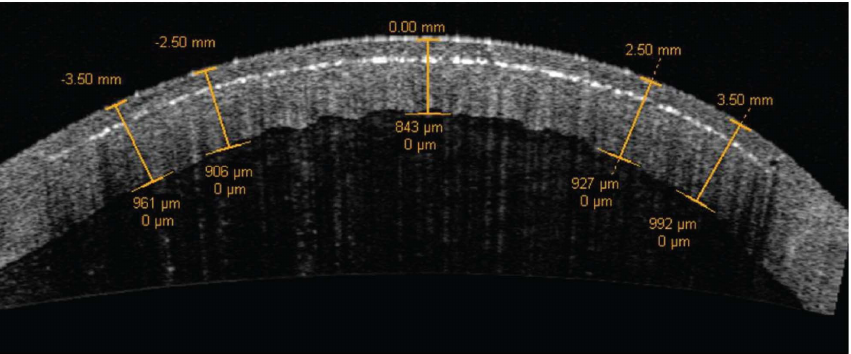
Figure 1. Achieved ablation depth. Representative OCT image taken after the laser cut. Ablation depth was measured in the central (0.00 mm), intermediate ( 6 2.50 mm) and mid-peripheral ( 6 3.50 mm) cornea. The middle of the cavitation bubble layer was considered for the identification of the ablation depth.